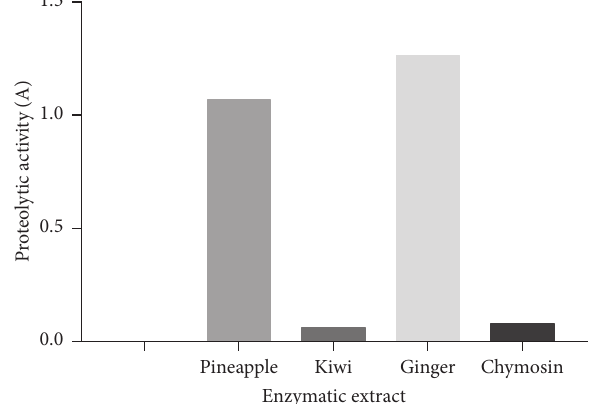
Figure 2: Proteolytic activity of enzymatic extract.